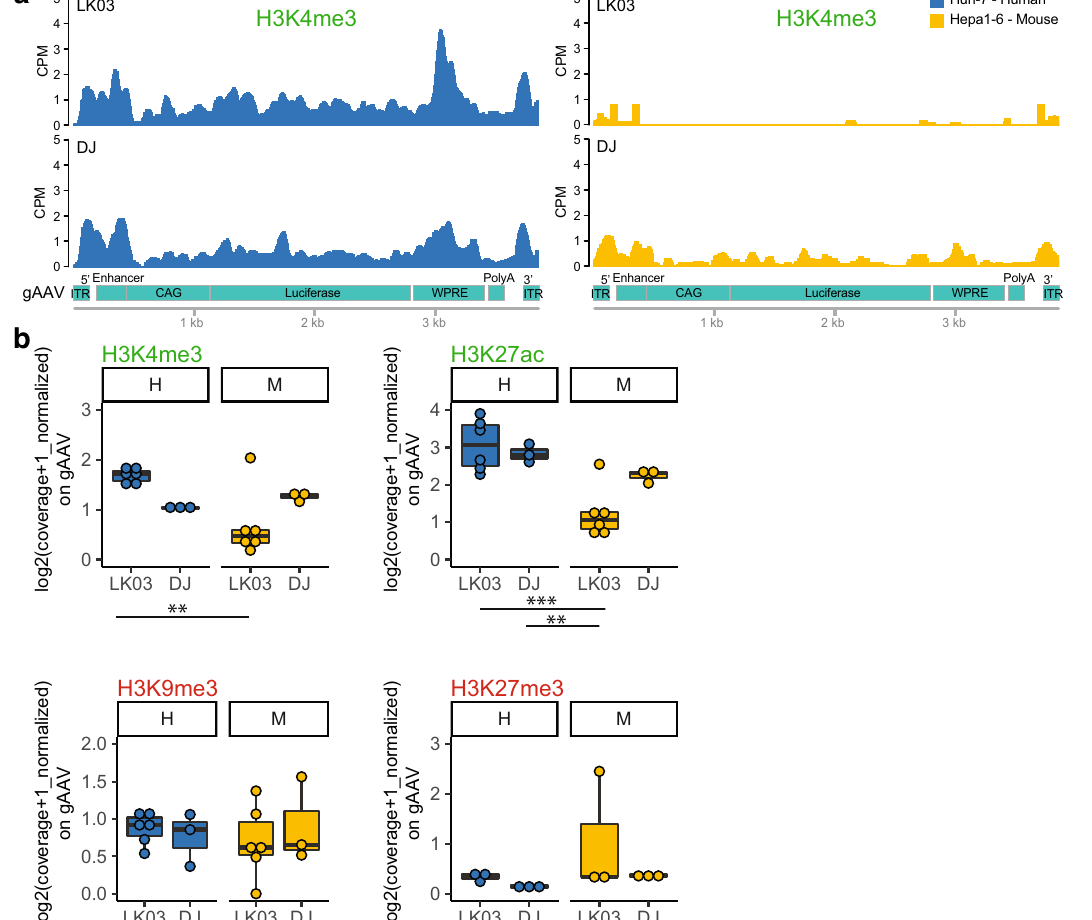
Fig. 2 | Species-speci fi c histone modi fi cations observed in rAAV genomes delivered with the AAV-LK03 capsid into mouse vs human cells. a H3K4me3 normalized (CPM) signal on AAV genome obtained from the Cut&Tag assay and next generation sequencing for Huh7 human and Hepa 1 – 6 mouse cell lines transduced with AAV-LK03 and AAV-DJ, as indicated. b Cut&Tag boxplots of nor- malized coverage on the AAV genome, for histone epigenetic modi fi cations - H3K4me3 and H3K27ac (active transcription), H3K9me3 and H3K27me3 (inactive transcription) for Huh7 human and Hepa 1 – 6 mouse cell lines transduced with AAV-LK03 and AAV-DJ. Statistics were performed with 2 way ANOVA and only ofincreasedvectorcopynumbers(Fig.3c),whichwerenearlyidentical between AAV-AM and AAV-LK03 in mouse cells.